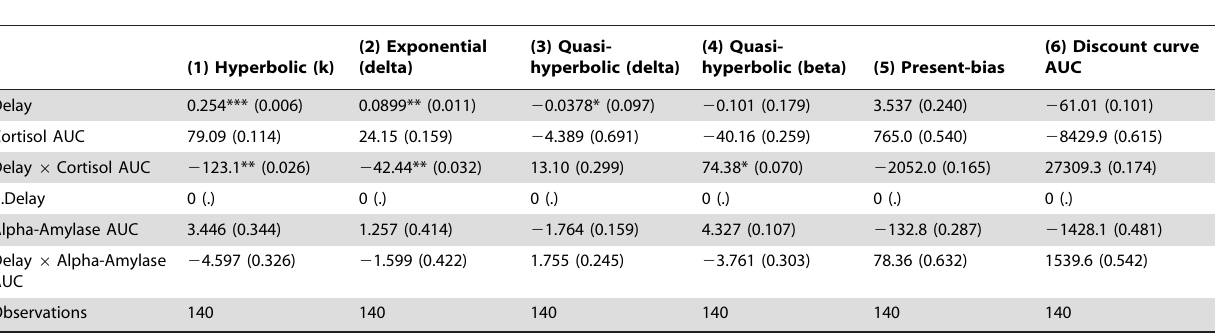
Table 3. Effect of hormonal reactivity to stress on time preference model parameters in all subjects (stress and control group pooled).